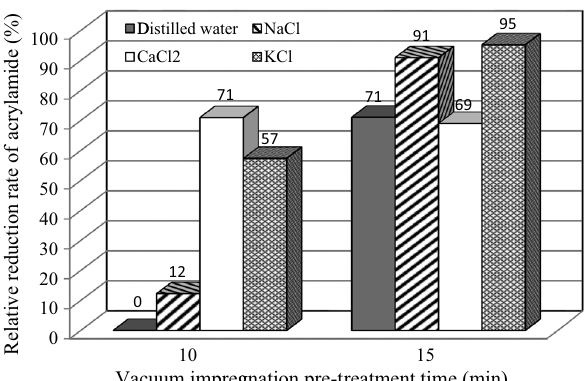
Figure 2: The e ff ect of VI pre - treatment solution and duration for raw potato strips on the relative reduction rates of acrylamide contents in French fries ( ratios are relative to the acrylamide contents of French fries produced from raw potato strips pre - treated by VI in distilled water for 10 min ) .